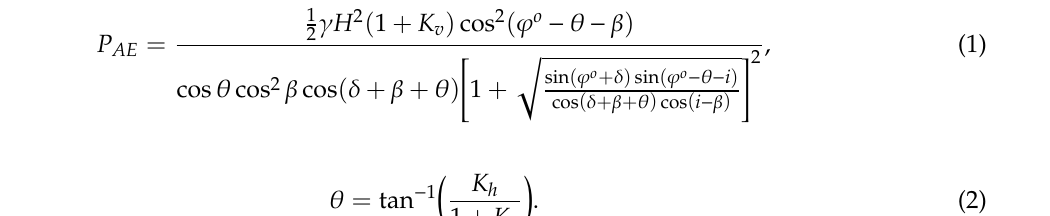
Figure 2. Stability checks for reinforced concrete retaining walls.